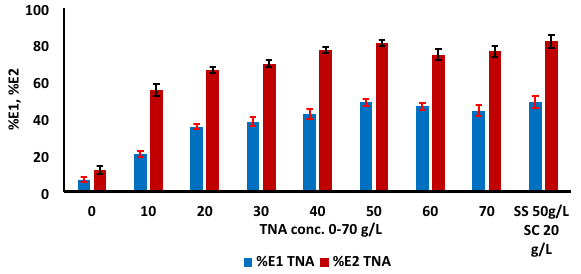
Figure 5. The effect of TNA concentration in primary and secondary exhaustion (%E1, %E2) for reactive dye RY 145, 2% owf, LR 1:40, %E1 40 °C after 30 min of starting dyeing, %E2 after 60 min of reach 70 °C using 50 g/L TNA compared with the conventional dyeing using SS 50 g/L and SC 20 g/L.